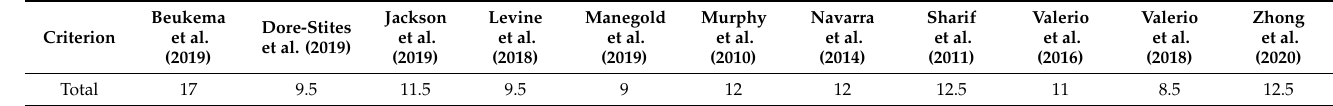
Table 3. Quality